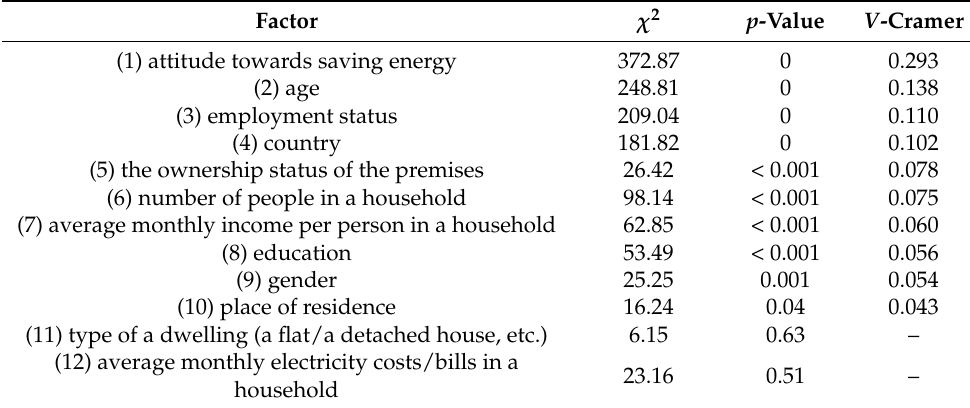
Table 2. Results of the chi-square test between the respondent’s type/segment and individual socioeconomic factors, along with the values of the Cramer’s V coefficient. Factor χ 2 p -Value V -Cramer (1) attitude towards saving energy 372.87 0